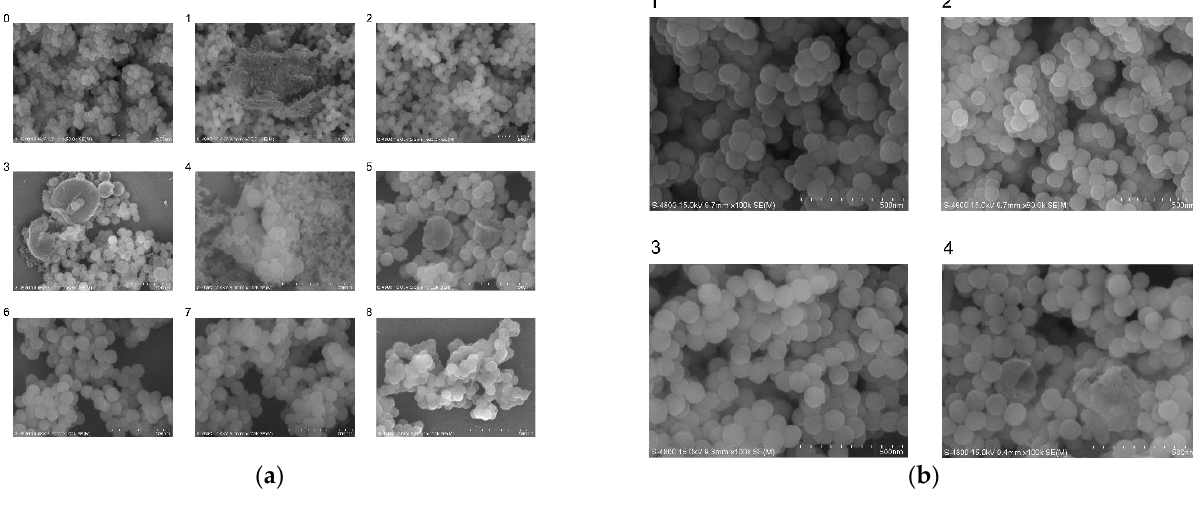
Figure 4. SEM imaging of silica particles with encapsulated DNA-traceable barcode vector prepared by different protocols. ( a ) Blank: silica particles without encapsulated DNA-traceable barcode; 1–8: the nanoparticles prepared according to the synthesis scheme A–H in Table 2; ( b ) 1–4: the nanoparticles prepared according to the synthesis scheme G0–G3 in Table 2.